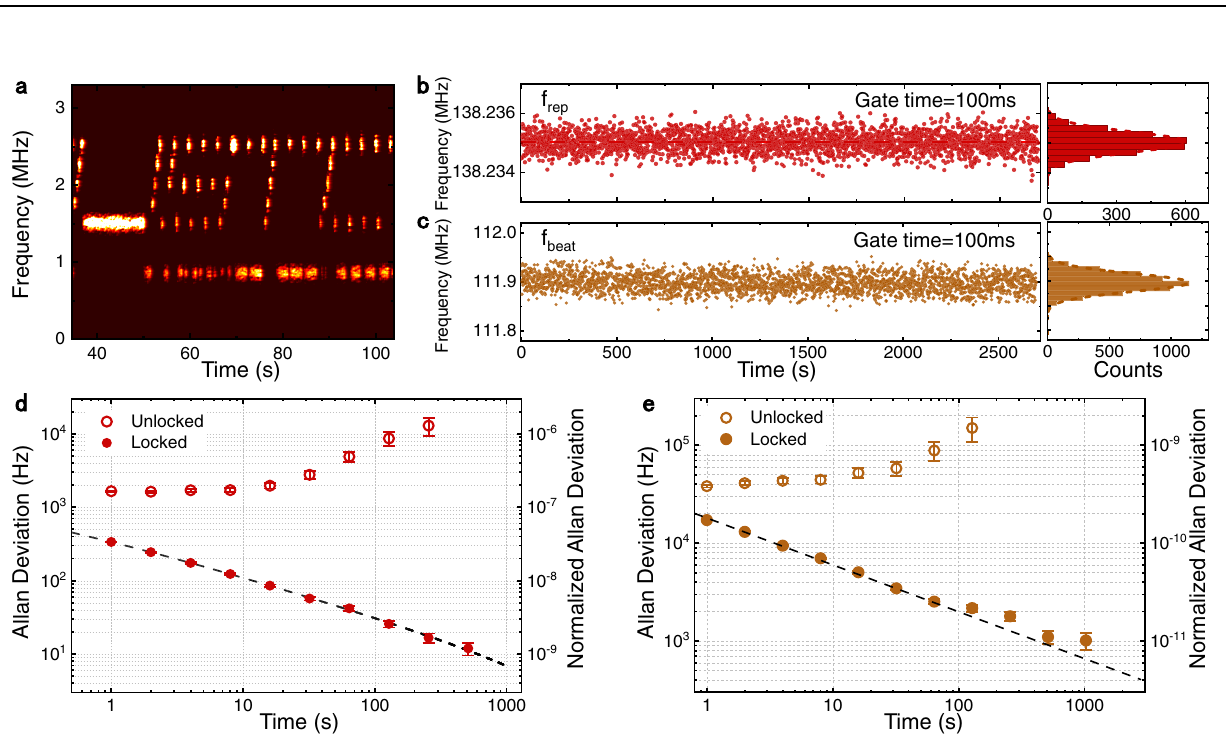
auxiliarylaser frequencyand the probelasersare shifted byAOMto determinethe signs of μ and Ω j . b The corresponding evolution of the repetition rate in the detection process. c – e Detailed evolution of the three beatnotes in ( a